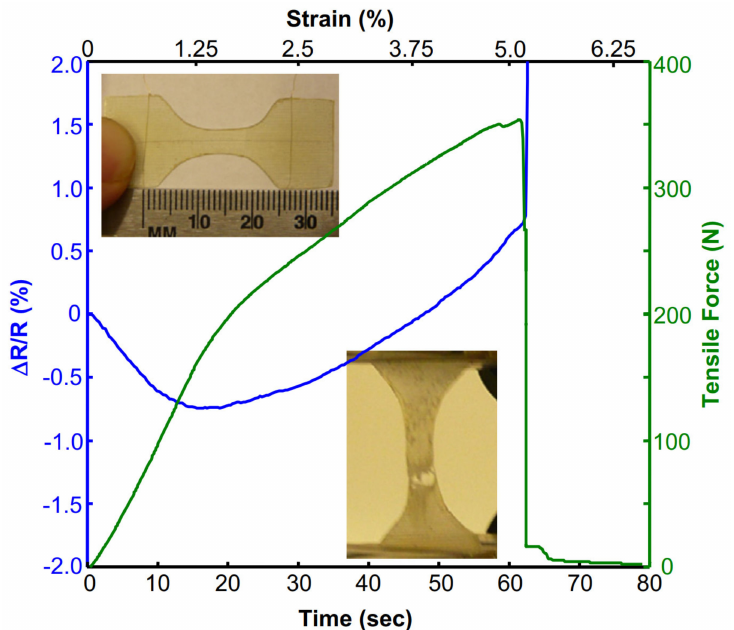
Figure 12. Piezoresistive response of glass SWCNT-FibSen sensor embedded in a 2-layer epoxy/glass fiber laminate that is subjected to tensile-to-failure test. Insets are the optical photographs of the dog-bone-shaped laminate before and after the test